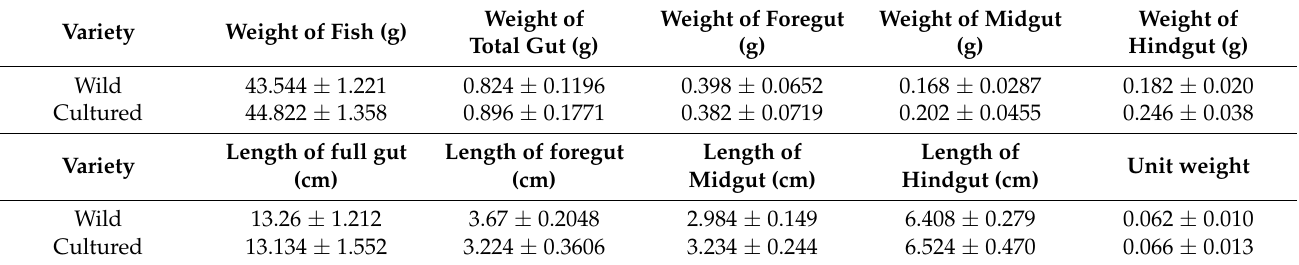
Figure 1. Intestinal anatomical structure of wild ( A ) and cultured ( B ) Hemibarbus maculatus. A large amount of fat on the gut surface of the cultured, but not wild fish, was found. Table 3. Morphological parameters of wild and cultured Hemibarbus maculatus. Table 3. Morphological parameters of wild and cultured Hemibarbus maculatus .